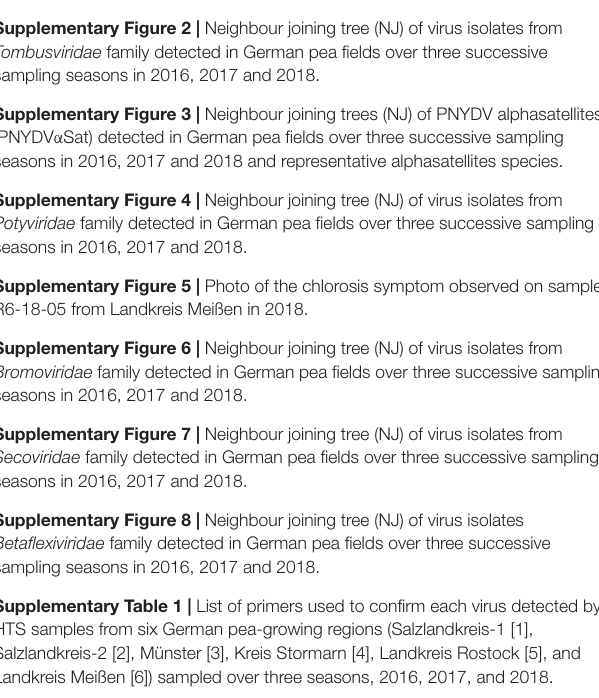
Supplementary Figure 1 | Neighbour joining tree (NJ) of virus isolates from Luteoviridae family detected in German pea fields over three successive sampling seasons in 2016, 2017 and 2018. Supplementary Figure 2 | Neighbour joining tree (NJ) of virus isolates from Tombusviridae family detected in German pea fields over three successive sampling seasons in 2016, 2017 and 2018. Supplementary Figure 3 | Neighbour joining trees (NJ) of PNYDV alphasatellites (PNYDV α Sat) detected in German pea fields over three successive sampling seasons in 2016, 2017 and 2018 and representative alphasatellites species. Supplementary Figure 4 | Neighbour joining tree (NJ) of virus isolates from Potyviridae family detected in German pea fields over three successive sampling seasons in 2016, 2017 and 2018. Supplementary Figure 5 | Photo of the chlorosis symptom observed on sample R6-18-05 from Landkreis Meißen in 2018. Supplementary Figure 6 | Neighbour joining tree (NJ) of virus isolates from Bromoviridae family detected in German pea fields over three successive sampling seasons in 2016, 2017 and 2018. Supplementary Figure 7 | Neighbour joining tree (NJ) of virus isolates from Secoviridae family detected in German pea fields over three successive sampling seasons in 2016, 2017 and 2018. Supplementary Figure 8 | Neighbour joining tree (NJ) of virus isolates Betaflexiviridae family detected in German pea fields over three successive sampling seasons in 2016, 2017 and 2018. Supplementary Table 1 | List of primers used to confirm each virus detected by HTS samples from six German pea-growing regions (Salzlandkreis-1 [1], Salzlandkreis-2 [2], Münster [3], Kreis Stormarn [4], Landkreis Rostock [5], and Landkreis Meißen [6]) sampled over three seasons, 2016, 2017, and 2018. Supplementary Table 2 | Statistics of the raw data of the generated reads from each pool of samples from six German pea-growing regions (Salzlandkreis-1 [1], Salzlandkreis-2 [2], Münster [3], Kreis Stormarn [4], Landkreis Rostock [5], and Landkreis Meißen [6]) sampled over three seasons, 2016, 2017, and 2018. Supplementary Table 3 | List of the viruses and their associated nucleic acid satellites detected by HTS and confirmed by RT-PCR in each pool of samples from six German pea-growing regions (Salzlandkreis-1 [1], Salzlandkreis-2 [2], Münster [3], Kreis Stormarn [4], Landkreis Rostock [5], and Landkreis Meißen [6]) sampled over three seasons, 2016, 2017, and 2018. The calculated incidence of each virus are indicated. Supplementary Table 4 | List of the detected virus sequences and their associated nucleic acid satellites from six German pea-growing regions (Salzlandkreis-1 [1], Salzlandkreis-2 [2], Münster [3], Kreis Stormarn [4], Landkreis Rostock [5], and Landkreis Meißen [6]) sampled over three seasons, 2016, 2017, and 2018. Their GenBank accession numbers, their closest sequence matchess on NCBI (BLASTn), percent of coverage of the reference genomes, the number of reads and the number and size range of the contigs generated by de novo assembly are indicated. Supplementary Table 5 | List of the unconfirmed virus sequences detected in the pools. Their closest sequence matches on NCBI (BLASTn), and the number and size range of the contigs generated by de novo assembly are indicated. Supplementary Table 6 | The metadata records (sample, season, category, plant, symptoms, and average temperature) of samples from six German pea-growing regions (Salzlandkreis-1 [1], Salzlandkreis-2 [2], Münster [3], Kreis Stormarn [4], Landkreis Rostock [5], and Landkreis Meißen [6]) sampled over three seasons, 2016, 2017, and